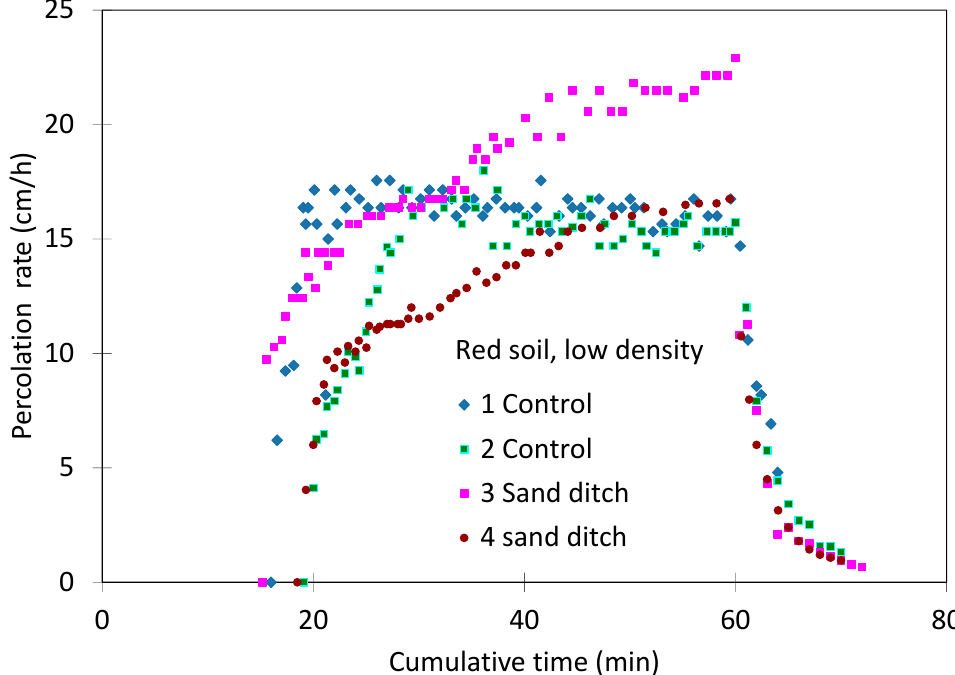
Figure 4. Percolated water rates measured at the drainage outlet of soil boxes for low-density clay soil.